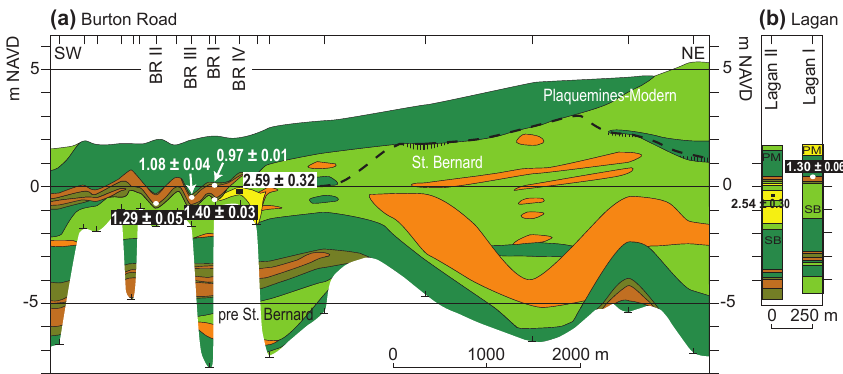
Figure 10. Cross section (a) Burton Road and two cores at (b) Lagan with the stratigraphic position of the OSL (Table 1) and radiocarbon (Table 2) samples. The radiocarbon age from Lagan I is from Törnqvist et al. (1996). See Fig. 6 for legend. PM: Plaquemines-Modern; SB: St. Bernard.